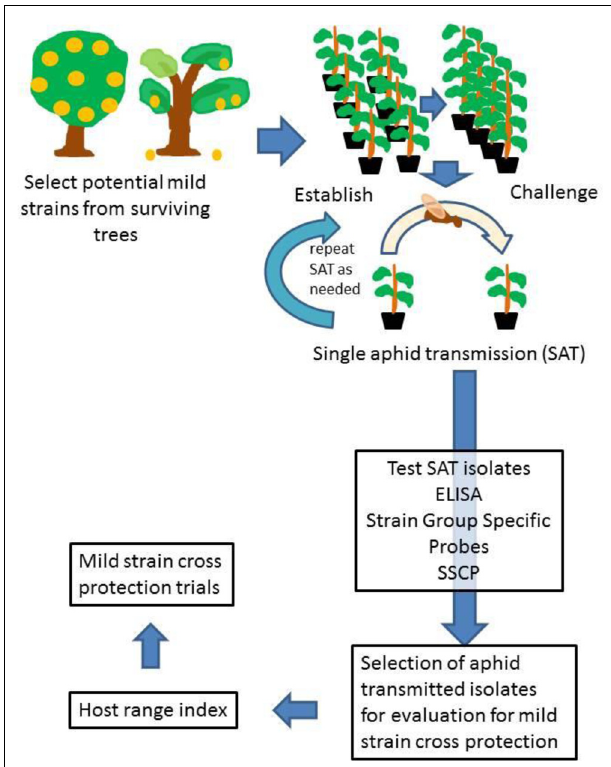
FIGURE 3 | Diagram showing the scheme followed to select mild isolates of CTV for use for mild strain cross